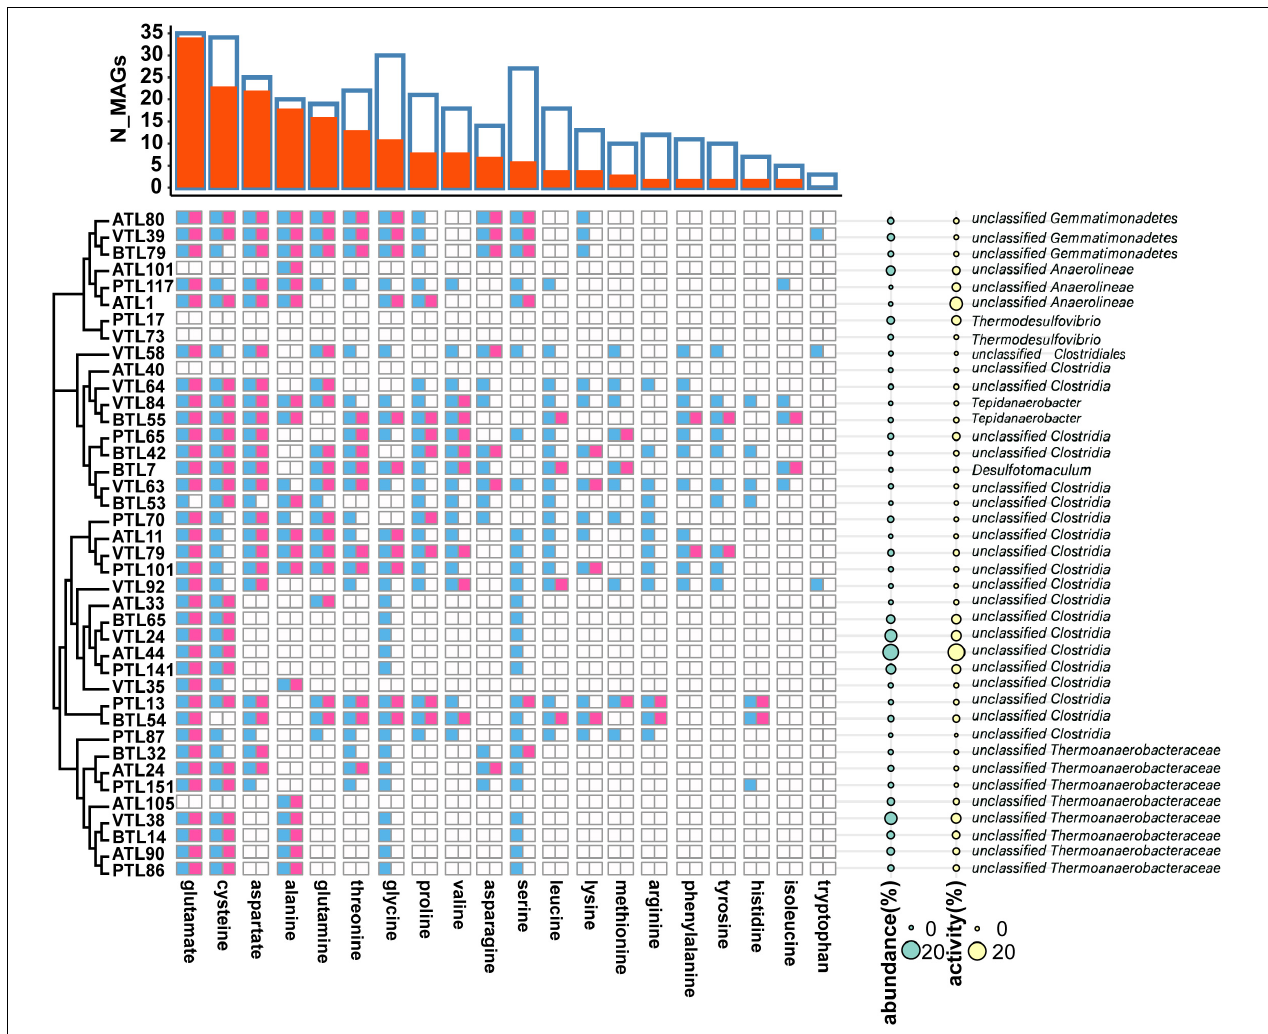
FIGURE 6 | The strategy of amino acid synthesis of syntrophic acetate oxidating bacteria (SAOBs) in different chemostats. The blue squares represent the presence of AA synthesis genes in the corresponding MAGs, whereas the red squares represent the activity of AA synthesis at transcriptomic level. Phylogenetic relationships among these MAGs are shown on the left side. On the right side, the cyan disks represent the abundance of the MAGs, whereas the yellow disks represent their transcriptional activities. The overall landscape of AA synthesis in SAOB MAGs is summarized on the top of the figure. Here, blue frames represent the number of MAGs containing the synthetic genes of the corresponding AA, and the red column represents the number of MAGs that actively transcribed the corresponding